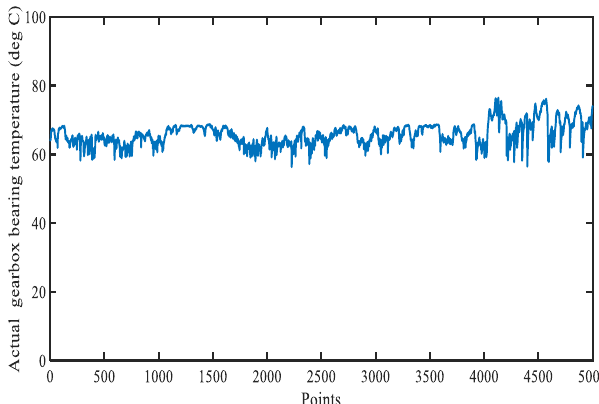
Figure 16. Mahalanobis distance value for prediction model input.